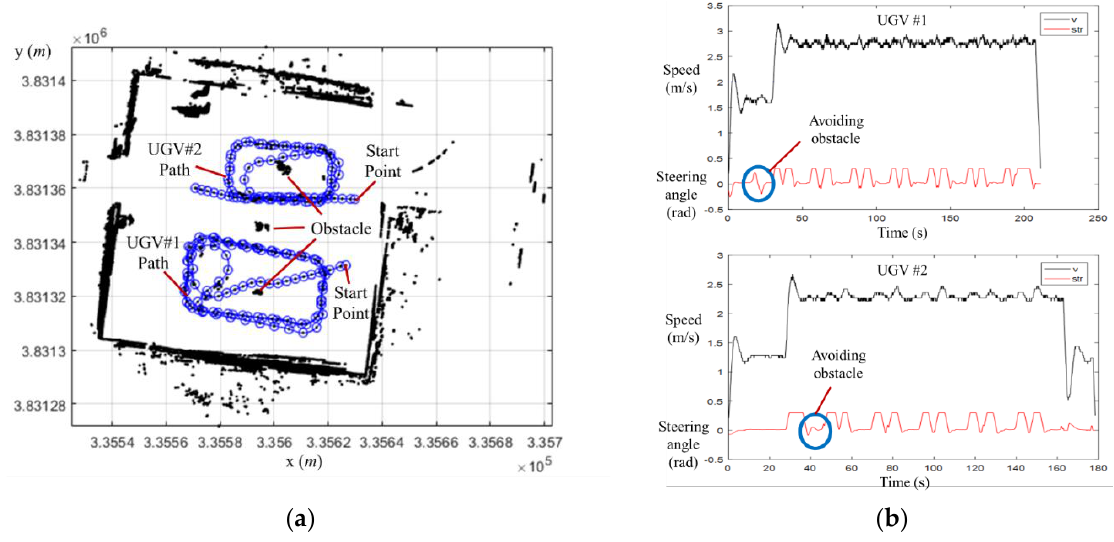
Figure 16. Log data of UGVs during operation of multiple UGVs/UAVs: ( a ) GPS log data of two UGVs and obstacle point cloud; ( b ) speed and steering log data.